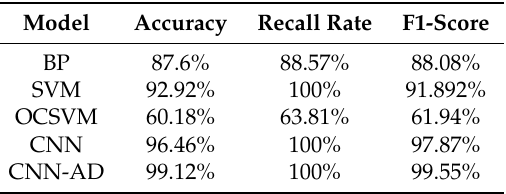
Table 4. Performance of